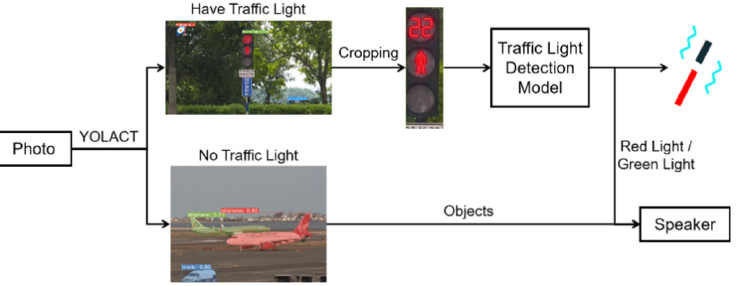
Figure 7. Schematic diagram of the object detection function and the traffic light detection function.